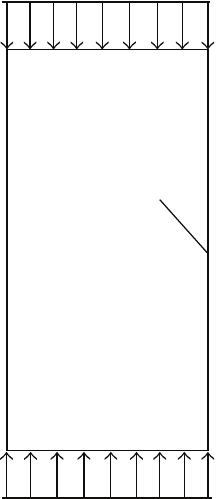
Figure 3: The numerical simulation